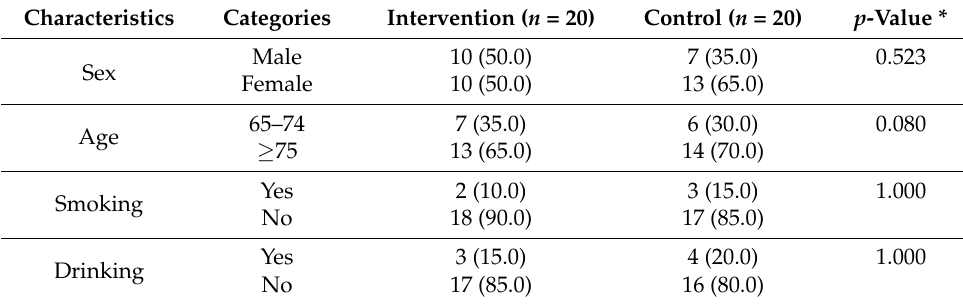
Table 1. Homogeneity of general characteristics of